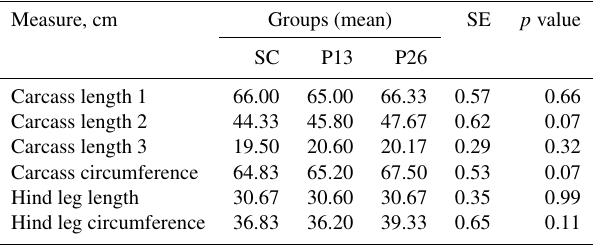
Table 6. Development measures of lamb carcasses.